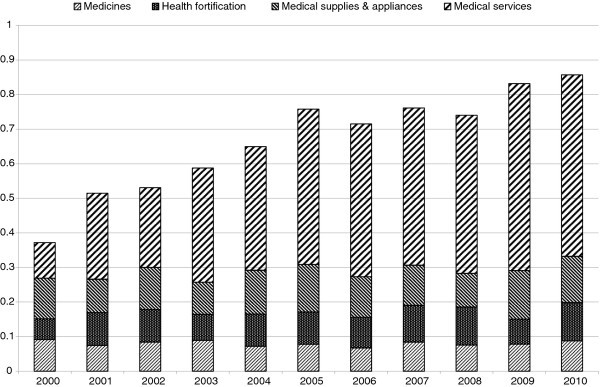
Trend and Decomposition of MDKC